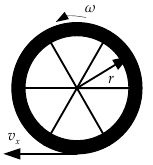
Figure 2. Wheel Figure 2. Wheel model.